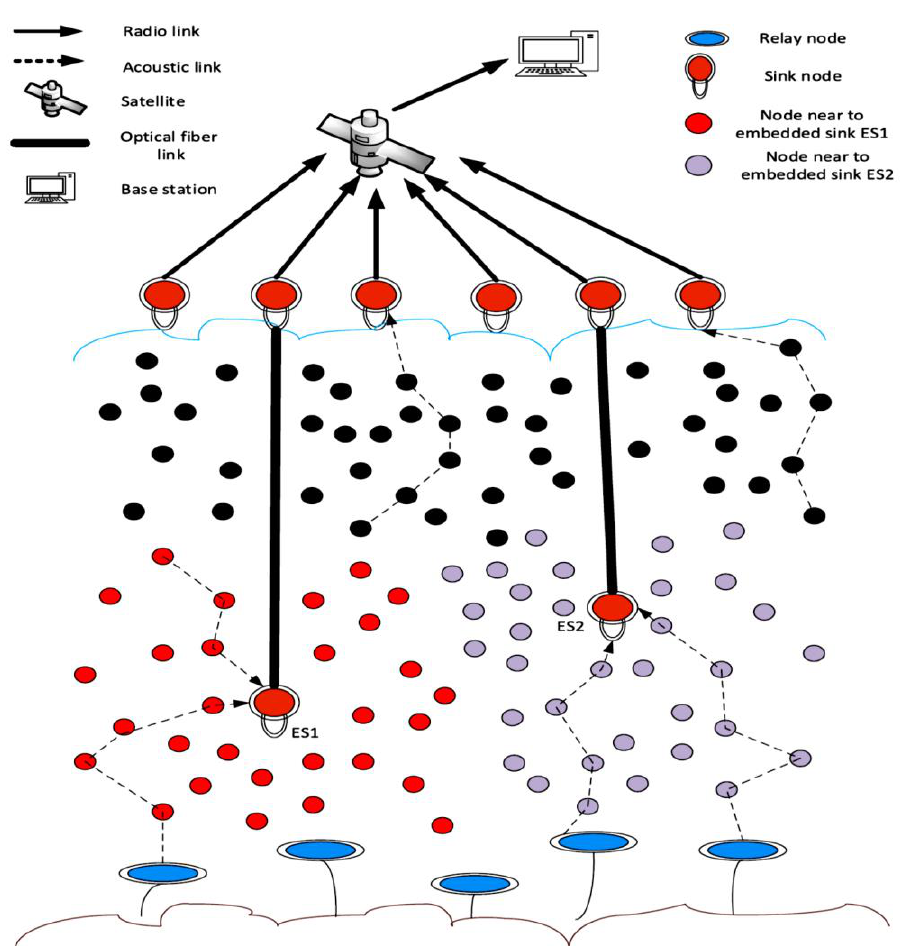
Figure 15. Network Topology with Two Embedded Sinks [54].